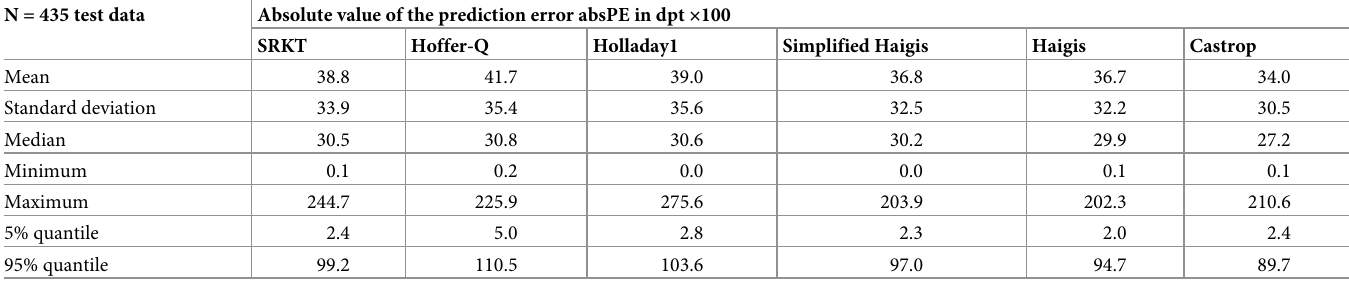
Table 3. Absolute value of the prediction error ( × 100) as the difference between achieved spherical equivalent and formula predicted spherical equivalent for the formulae under test. N = 435 test data